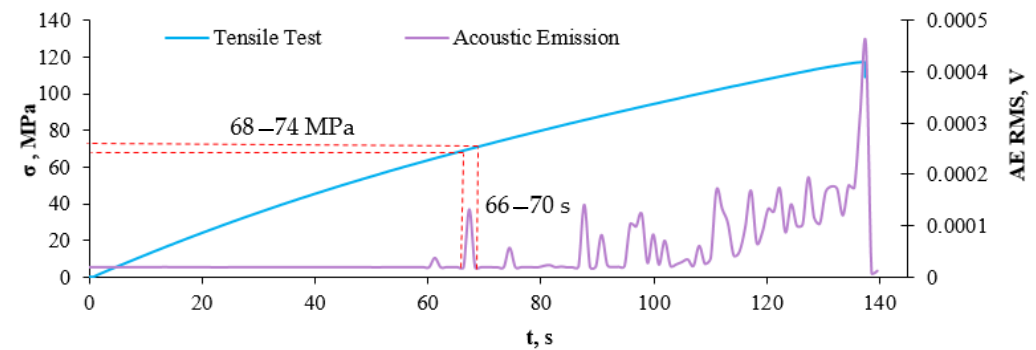
Figure 14. A metric entropy diagram applied on a strain diagram in the function of time, for a composite sample with 10% recyclate content.